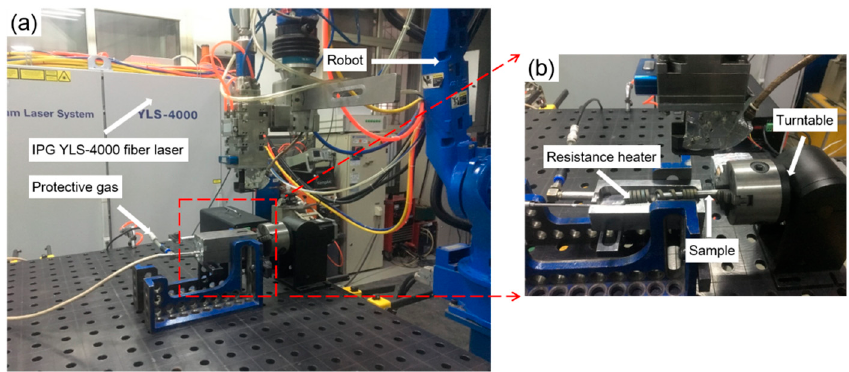
Figure 3. ( a ) Fiber laser welding system; ( b ) tooling and preheating device used in this